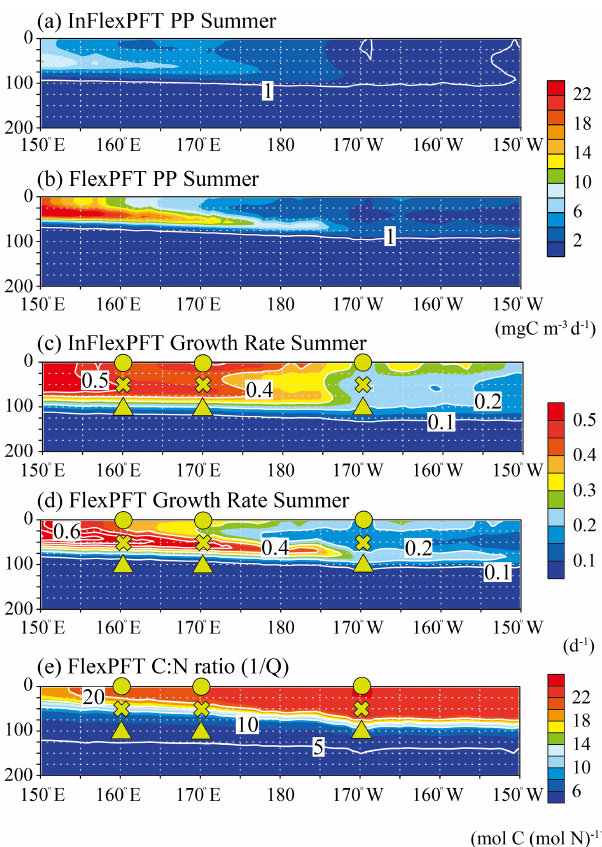
Figure 4. Comparison of the vertical distributions of (a) – (b) sum- mer primary production (mg Cm − 3 d − 1 ) and (c) – (d) summer phy- toplankton growth rate (d − 1 ) between the two models, and (e) the vertical distribution of the summer C:N ratio in the FlexPFT along 165 ◦ E (north–south section; shown by white circles in in Fig. 1). These figures show the average values for the summer during the 2000–2019 period.